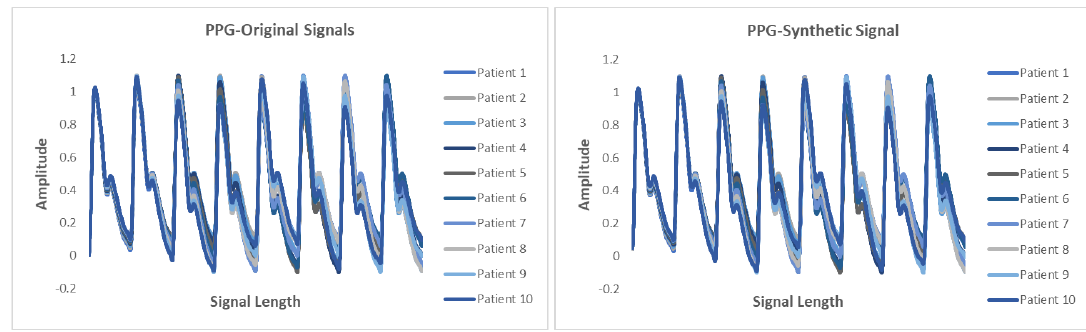
Figure 9. Comparison between original and synthetic PPG signals.